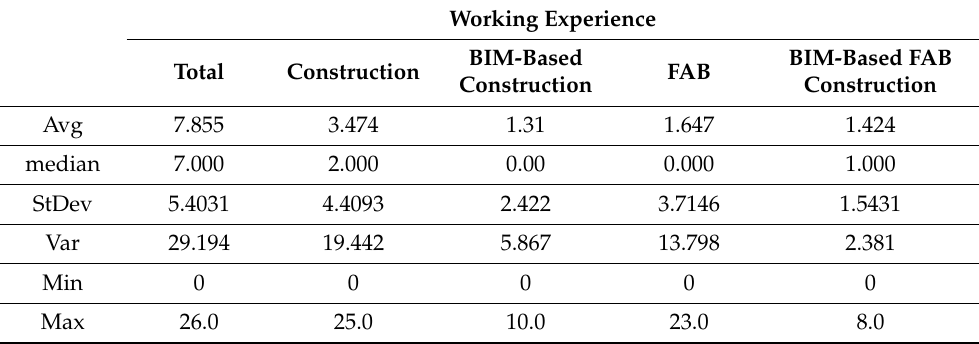
Table 6. Descriptive statistics: the designer group (N =